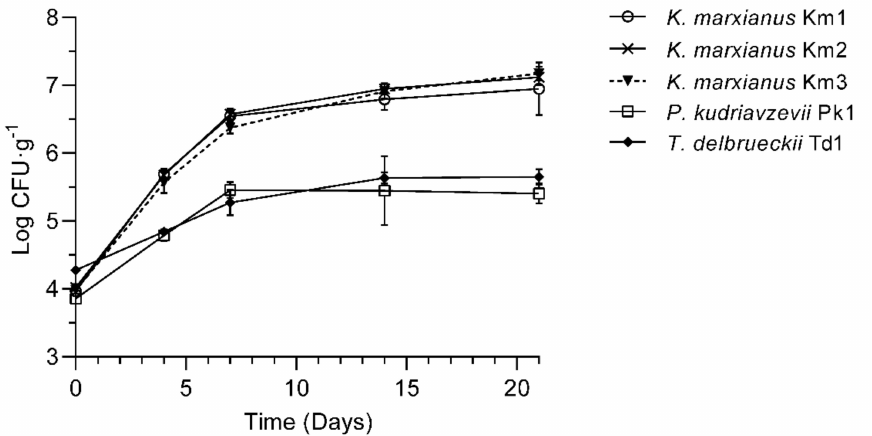
Figure 1. Viable counts (log CFU · g − 1 ) of yeasts K. marxianus (strains Km1, Km2 and Km3), P. kudriavzevii Pk1 and T. delbrueckii Td1 grown in skyr at 8 ◦ C for 21 days. Mean values and SD from triplicate experiments are presented.